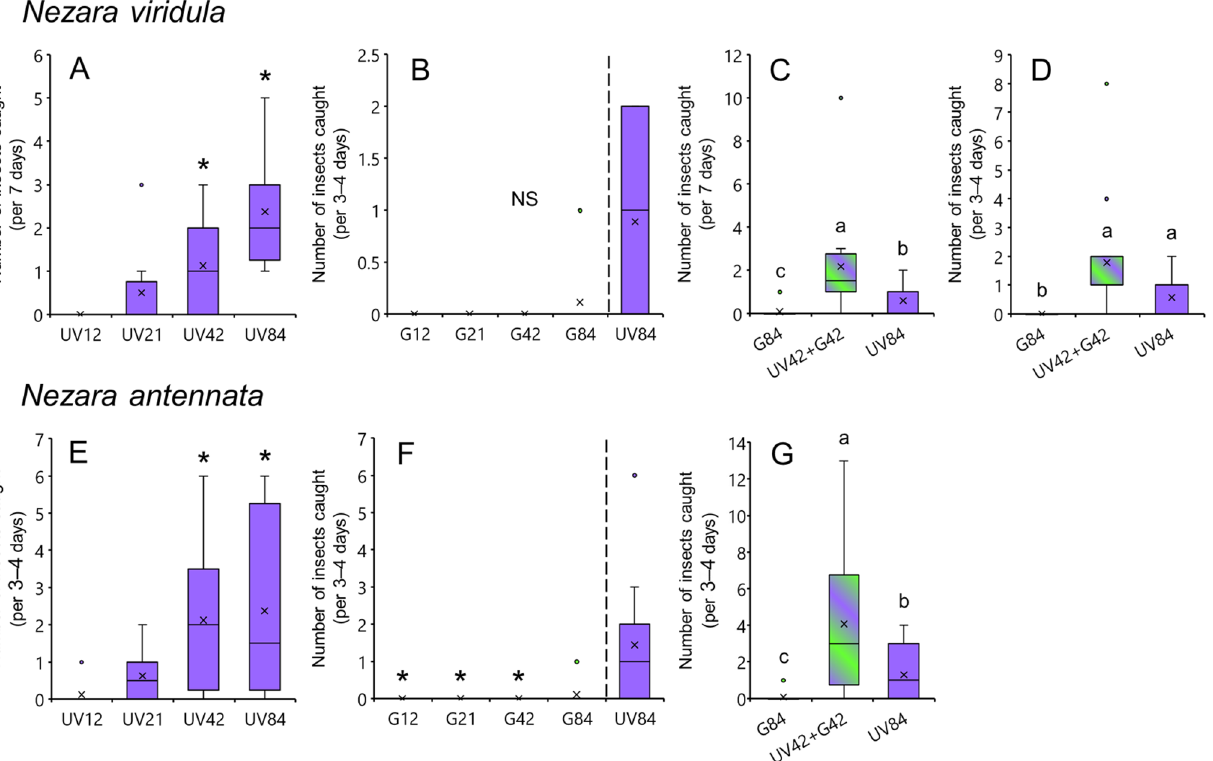
Figure 1. Attractiveness of different light sources to Nezara viridula (top) and N. antennata (bottom). The graphs on the left present the attractiveness of UV light at different intensities, the middle graphs present the attractiveness of green light at different intensities, and the graphs on the right present the attractiveness of the combined UV and green light. The number after UV or G indicates the number of LEDs used for the light source. Boxplots represent the median value (horizontal line), mean value (cross mark), interquartile range (boxed area), maximum and minimum values (vertical bar), and outlier value (circle). Asterisks indicate significant differences ( p < 0.05) between 12 UV-LEDs in graphs A and E (Shirley–Williams test), and between 84 UV-LEDs in graph F (Wilcoxon signed-rank test). Different letters in the same graph indicate significant differences between light sources (Wilcoxon signed-rank test with Bonferroni correction; p < 0.05 in graphs C, D, and G). NS not significant ( p > 0.05). The data in graphs A and C were obtained from field experiments conducted in Okinawa, data in graphs B, D, F, and G were collected in Yamaguchi, and data in graph E were collected in Niigata. Due to time constraints, the insects captured in traps were counted every 7 days in Okinawa, and every 3–4 days in Niigata and